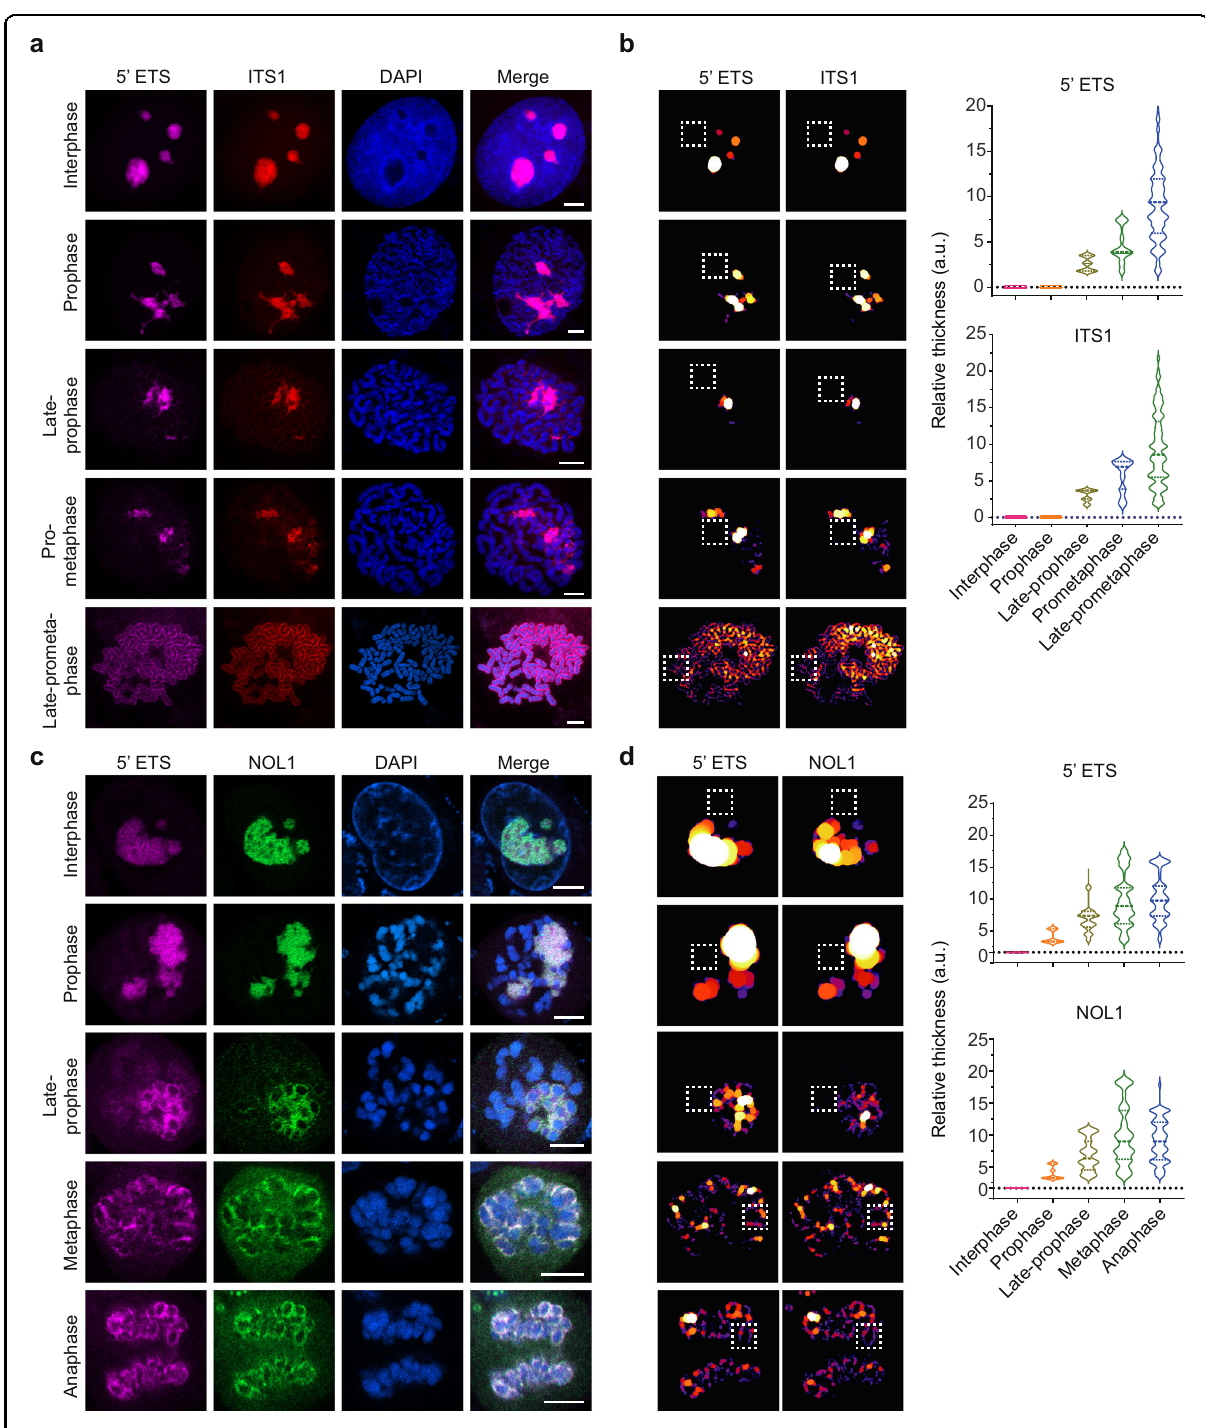
Fig. 3 rRNA dynamically covers mitotic chromosomes. a The localization of pre-rRNAs from interphase to metaphase. pre-rRNAs were examined by RNA FISH in mitotic spreads. Scale bar, 5 μ m. b The RNA FISH signals were analyzed by “ Local Thickness ” of Fiji. c The localization of pre-rRNAs and NOL1 from interphase to anaphase. 45S pre-rRNA was examined by RNA FISH, and NOL1 was detected by a fused EGFP tag. Scale bar, 5 μ m. d The RNA FISH and EGFP signals were analyzed by “ Local Thickness ” of